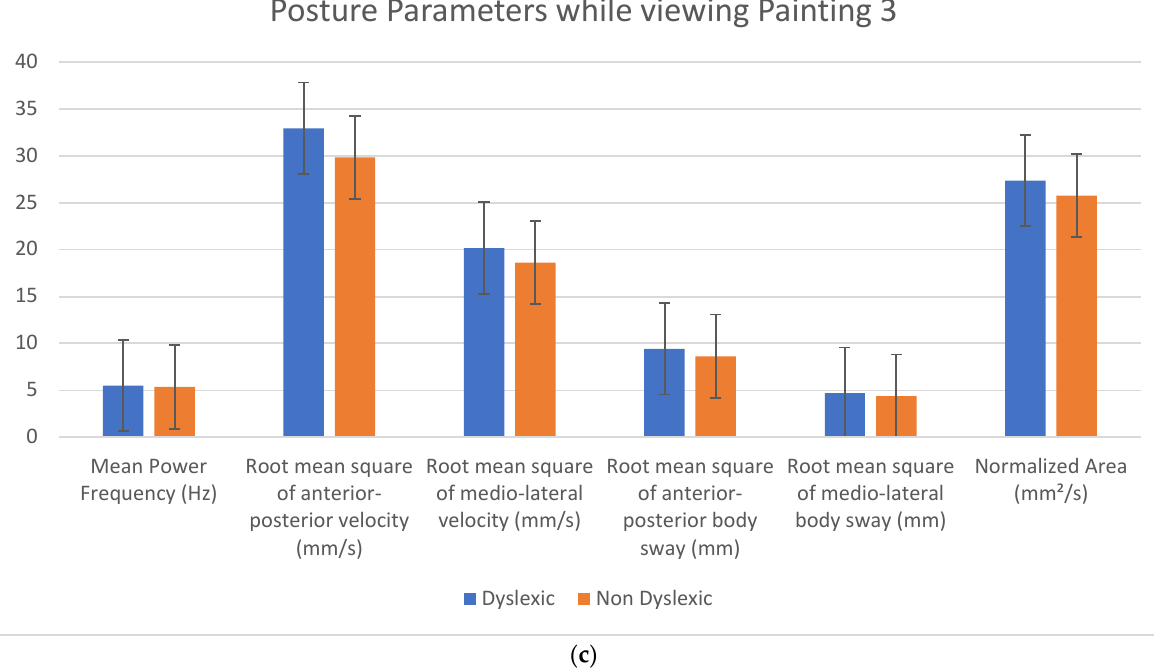
Figure 3. ( a ). Postural parameters in the dyslexic and non-dyslexic populations while viewing Painting 1: Bridget Riley, Blaze 1 , 1962. ( b ) Postural parameters in the dyslexic and non-dyslexic populations while viewing Painting 2: Bridget Riley, Movement in Squares , 1961. ( c ) Postural parameters in the dyslexic and non-dyslexic populations while viewing Painting 3: Bridget Riley, Cataract 3 , 1967.